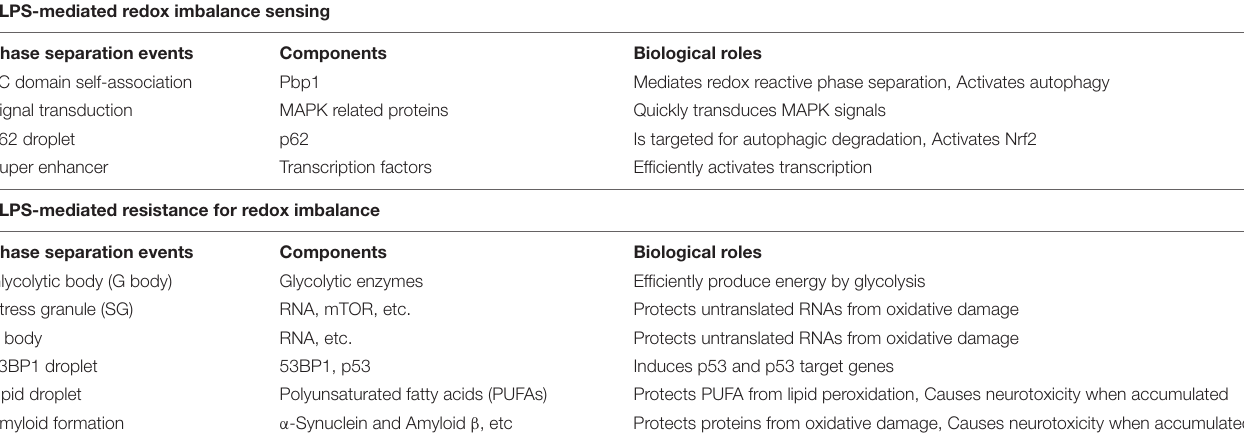
TABLE 1 | Roles of phase separation-associated biological events related to redox